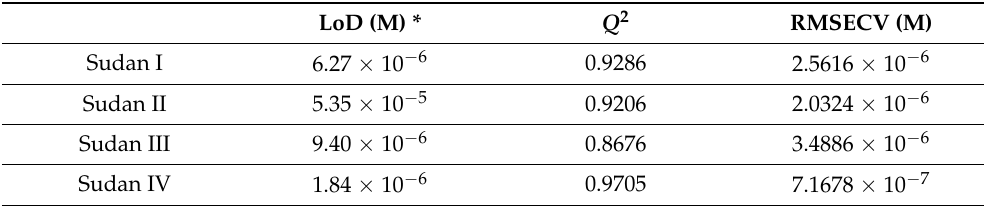
Table 1. Results from the four PLS − R models for the individual dilution series.